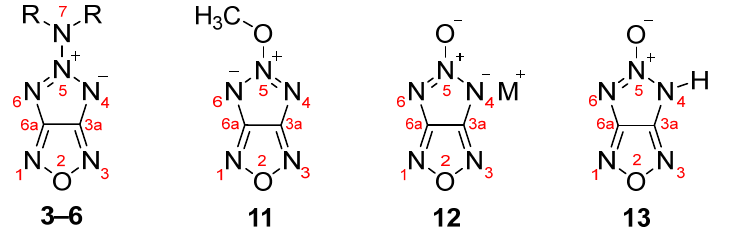
Figure 3. Compounds 11 – 13 .